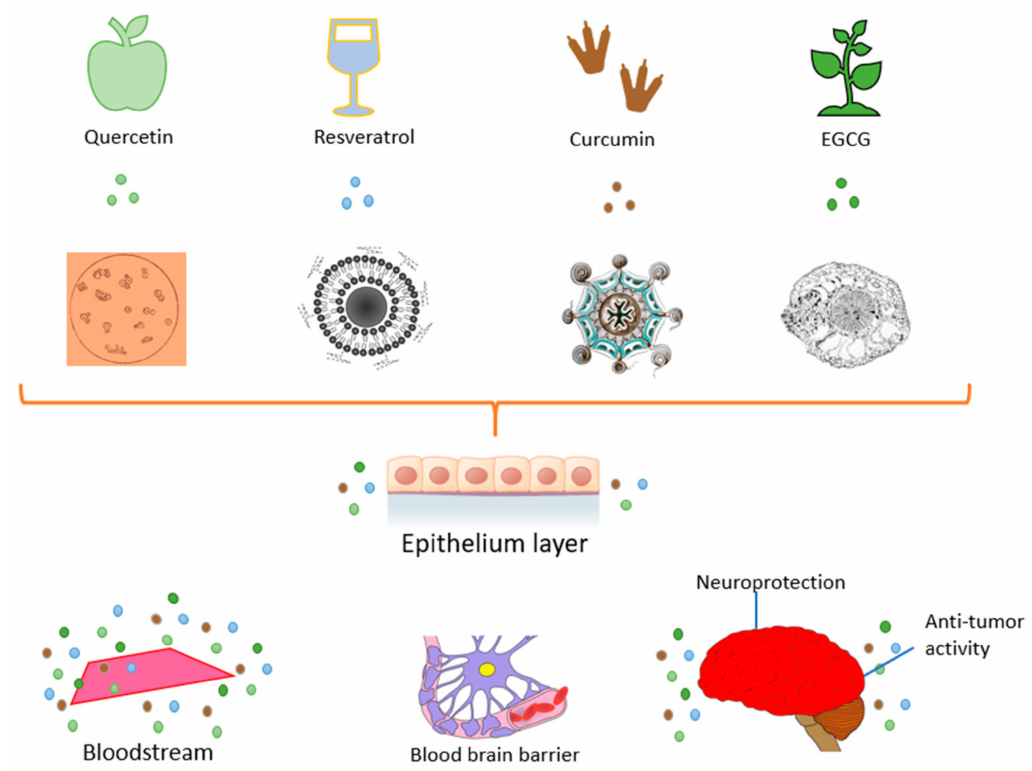
Figure 10. Therapeutic potential of nano flavonoids on breast